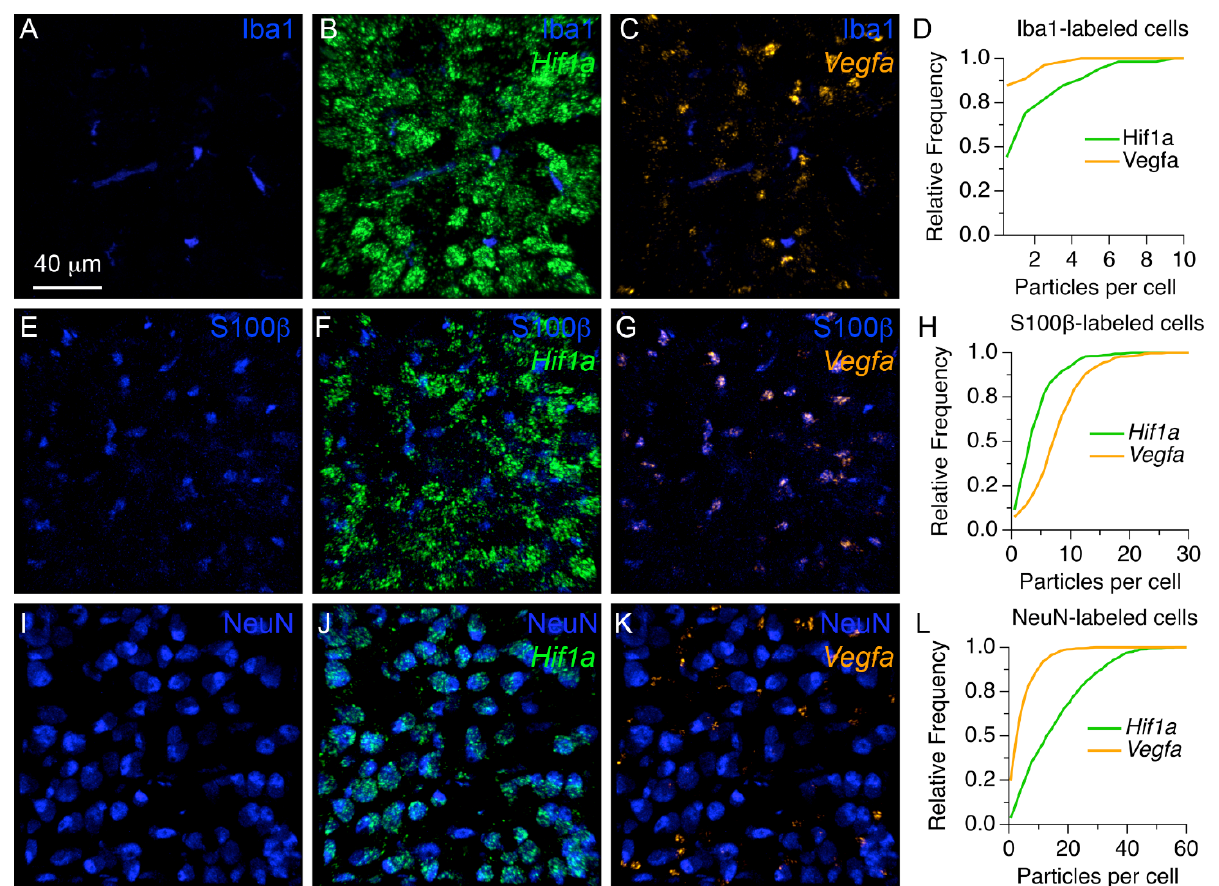
Figure 7. Localization of Hif1a and Vegf mRNAs in MNTB cells at P7. ( A – C ) Exemplar 3D rendering views show the localization of anti-Iba1 labeled cells ( A ) with Hif1a ( B ) or Vegf ( C ) mRNAs. ( D ) Cumulative histograms of the number of mRNA particles per anti-Iba1 labeled cell. ( E – G ) Exemplar 3D renderings show the localization of S100b-labeled cells ( E ) with respect to Hif1a ( F ) or Vegf ( G ) mRNAs. Note the obvious overlap of Vegf signal with S100b-labeled cells. ( H ) Cumulative histograms of the number of mRNA particles per anti-S100b labeled cell. ( I – K ) Exemplar 3D renderings of anti-NeuN labeled cells in the MNTB ( I ), with respect to Hif1a ( J ) or Vegf ( K ) mRNAs. Note the overlap between Hif1a signal and anti-NeuN labeling. ( L ) Cumulative histograms of the number of mRNA particles per anti-NeuN labeled cell. Scale bar in ( A ) applies to ( B , C , E – G,I – K ).